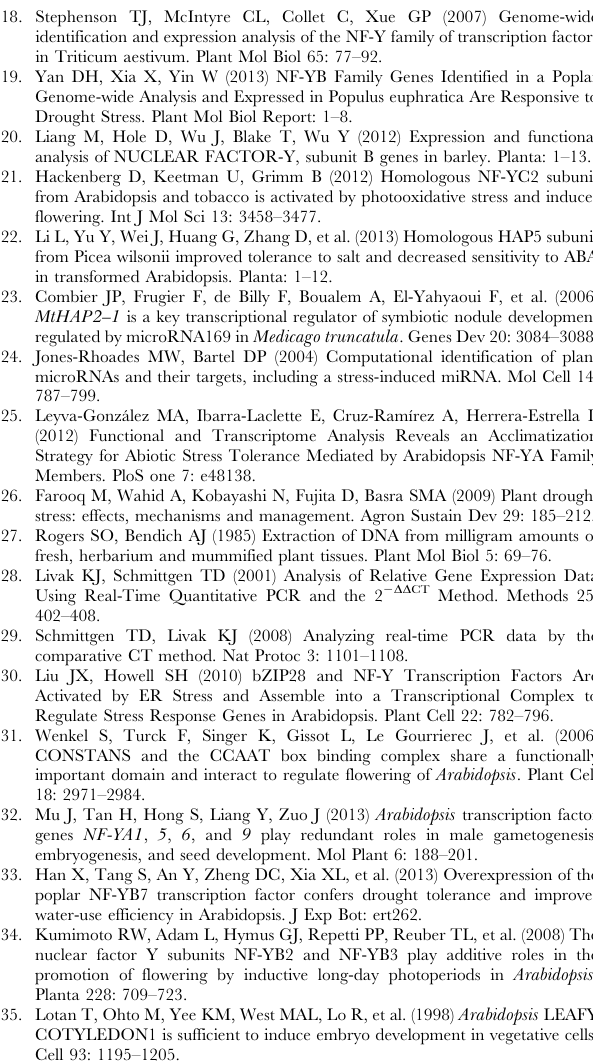
Walking. Table S2 Relative water content (RWC) of drought- stressed plants. Plants were treated with 10%, 15% and 20% (w/v) PEG6000 solution for 24